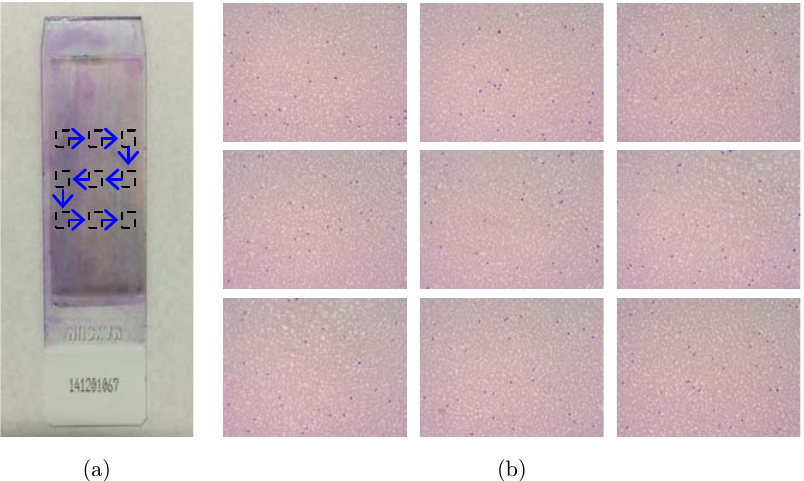
Fig. 2. Pre-scanning procedure with low power objective. (a) Blood smear and pre-scanning routine and (b) captured low power images while